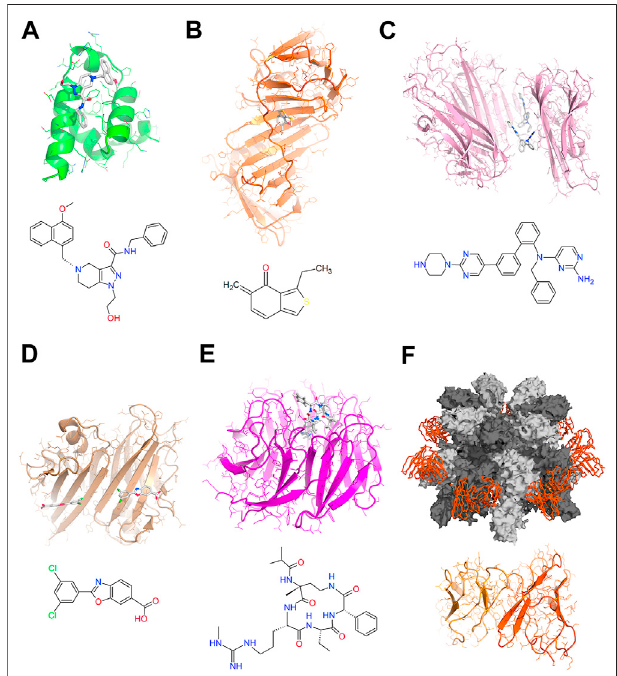
FIGURE 1 | Selection of modulators targeting PPI (A) Structure of PEX14 bound the inhibitor [1-(2-hydroxyethyl)-5-[(4-methoxynaphthalen-1-yl) methyl]- ∼ (N)-(phenylmethyl)-6,7-dihydro-4 ∼ (H)-pyrazolo (4,3-c)pyridine-3- carboxamide) that ef fi ciently disrupts the PEX14-PEX5 interaction to treat trypanosomiases (Dawidowski et al., 2017) (B) Structure of human DNA polymerase processivity factor UL44 in complex with the covalent allosteric inhibitor {(5-[(dimethylamino)methylene-3-(methylthio)-6,7-dihydrobenzo (c) thiophen-4(5H)-one]} that blocks the UL44-UL54 peptide interactions to treat human cytomegalovirus infections (Chen et al., 2017) (C) Structure of human TNF α in complex with the inhibitor JNJ525 {(N)4-(phenylmethyl)- ∼ (N)4-{2-[3- (2-piperazin-1-ylpyrimidin-5-yl)phenyl]phenyl}pyrimidine-2,4-diamine} that blocks the TNF-TNFR1 signaling stabilizing a distorted TNF α complex (McMillan et al., 2021) (D) Structure of human Transthyretin in complex with the ligand Tafamidis [2-(3,5-dichlorophenyl)-1,3-benzoxazole-6-carboxylic acid] a potent and selective stabilizer that inhibits the amyloid cascade for the treatment ofamyloid cardiomyopathy (Maurer et al., 2018) (E) Structure ofthe WD repeat domain fi ve in complex with the macrocyclic peptidomimetic MM- 589 {N-[(3R,6S,9S,12R)-6-ethyl-12-methyl-9-[3-(N ′ - methylcarbamimidamido)propyl]-2,5,8,11-tetraoxo-3-phenyl-1,4,7,10- tetraazacyclotetradecan-12-yl]-2-methyl propanamide} that blocks the WDR5-mixed lineage leukemia (MLL) protein-protein interaction (Karatas et al., 2017) (F) Structure of the anthrax toxin prepore in complex with the neutralizing Fab portion of the antibody cAb29 (Hoelzgen et al.,